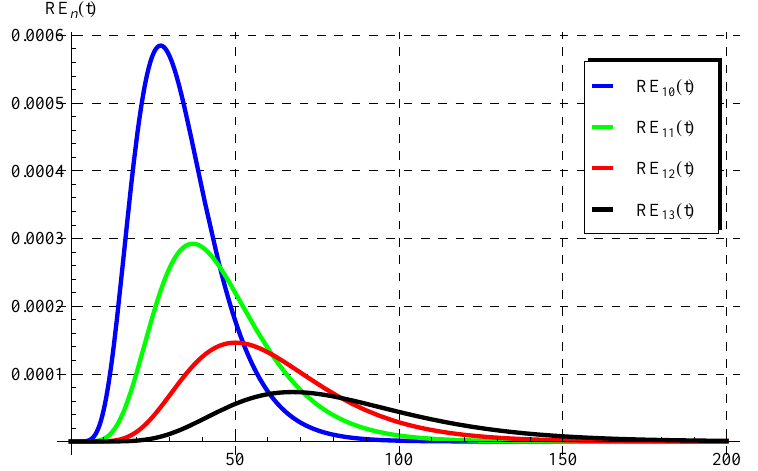
Figure 6. The residuals RE r ( t ) , r = 10,11,12,13 in Equation (76) at λ = 1, a = − 2, b = 1, and c = 3